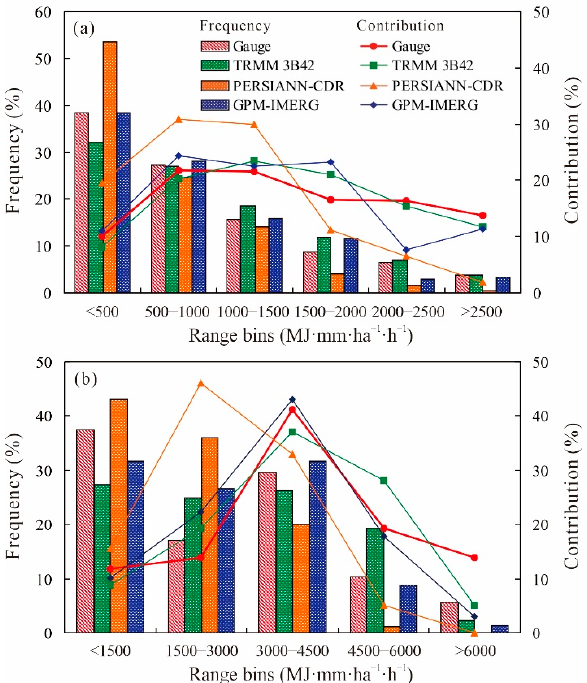
Figure 4. Distribution of frequencies and corresponding contribution rates of rainfall erosivity in different intensity categories (( a ): monthly scale; ( b ): seasonal scale).